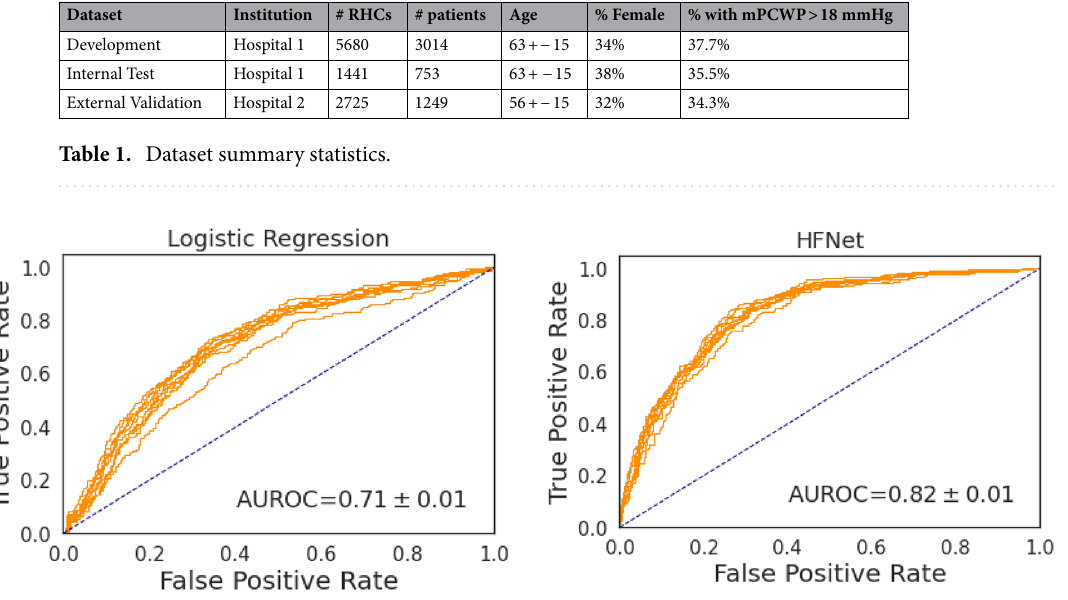
Figure 1. Receiver Operator Characteristic on the internal holdout set for ( a ) Logistic Regression baseline and ( b ) HFNet, showing 10 bootstraps. HFNet obtains significant improvements over the logistic regression baseline (paired t-test, p <